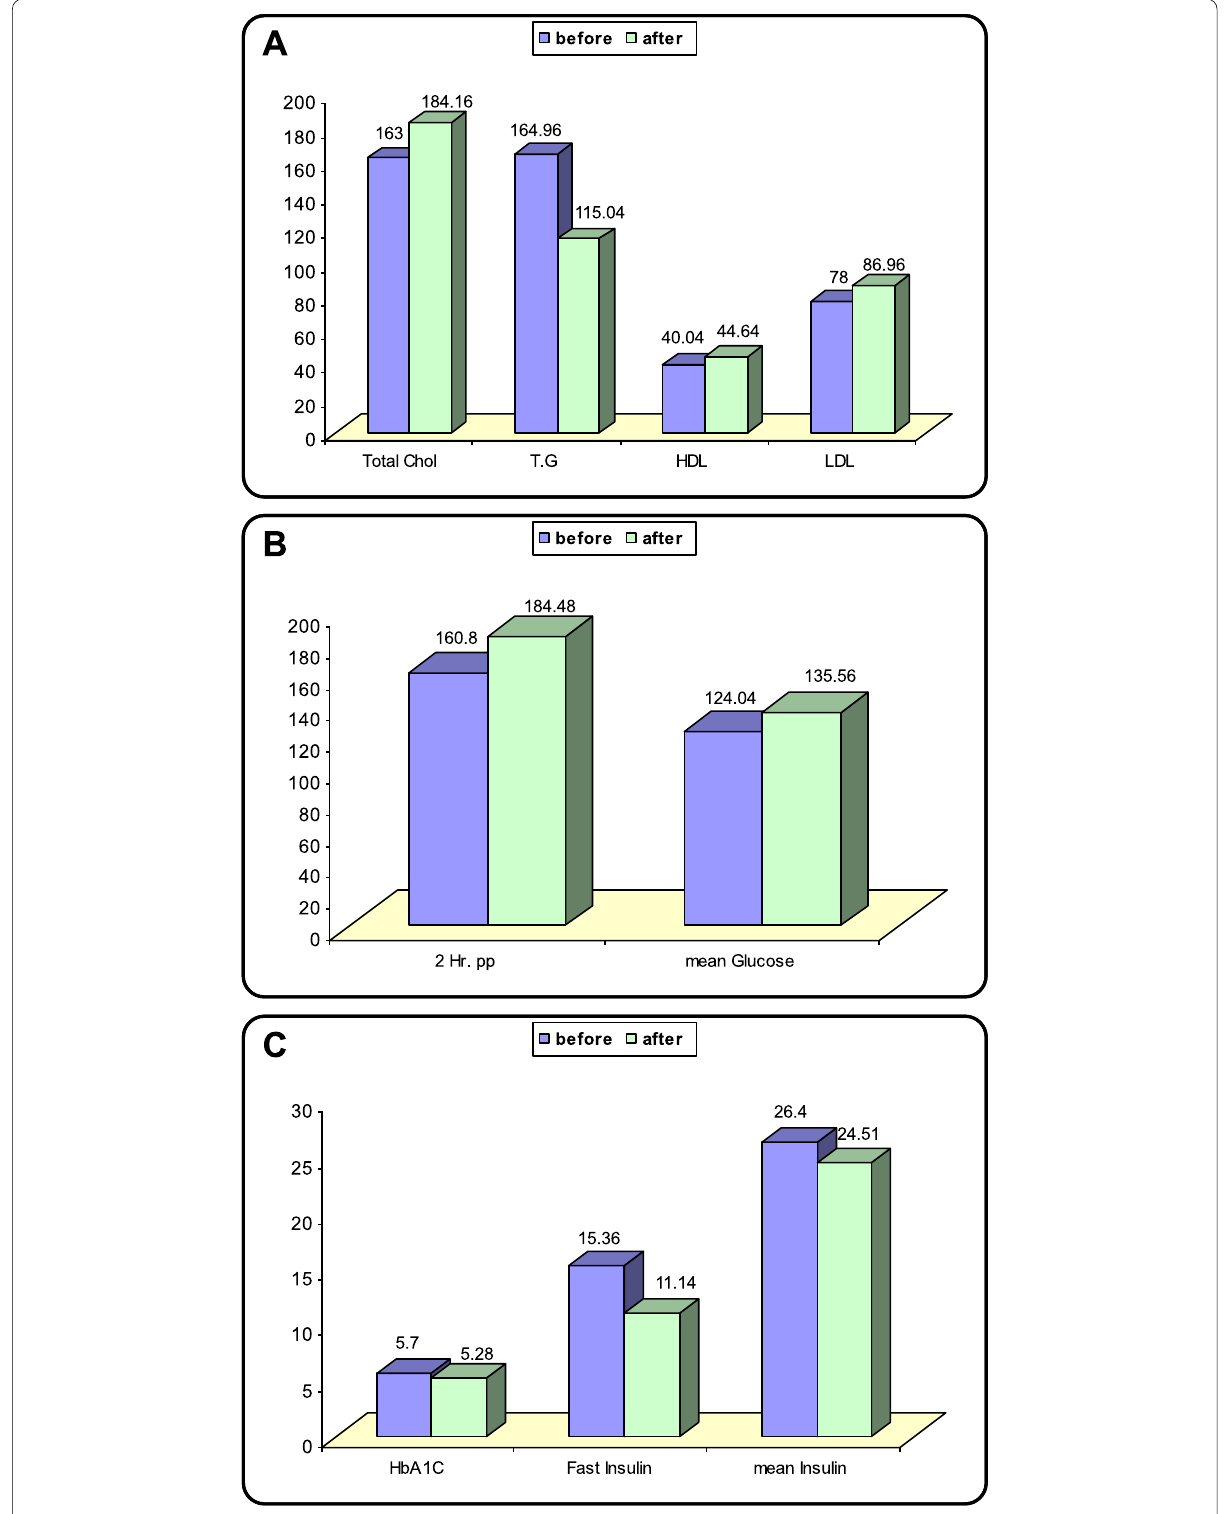
Fig. 3 A Comparison between lipid profiles at baseline and after SVR at 12 weeks among patients in group B. B Comparison between 2‑h postprandial blood glucose and mean glucose levels at baseline and after SVR at 12 weeks among patients in group B. C Comparison between HbA1C, fasting insulin, and mean insulin levels at baseline and after SVR at 12 weeks among patients in group